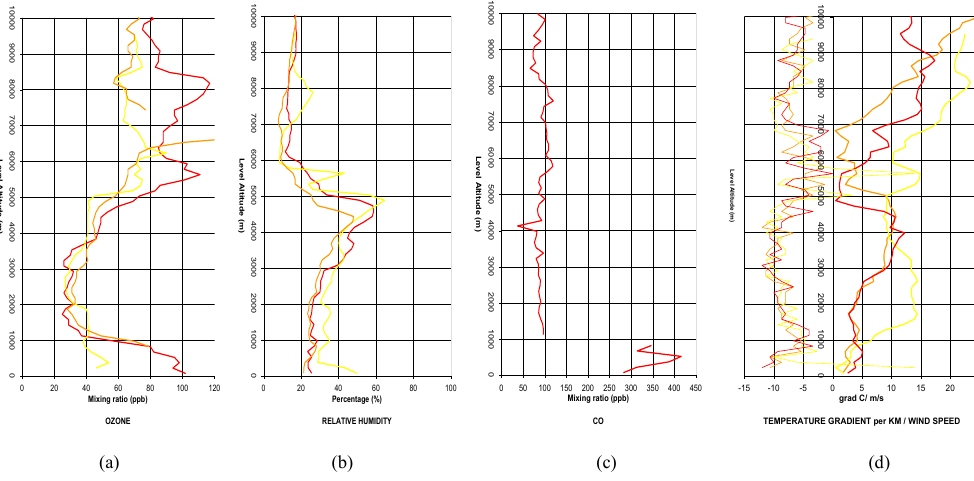
Fig. 4. (a) Vertical profiles of summer (JJA) ozone over the eastern Mediterranean airport of Cairo during the 2-day low ozone period in the lower troposphere, 26–27 July 2002 (Profiles: MA20020726043 (red), MD20020726023 (orange), MA20020727013 (yellow)); (b) same as (a) but for relative humidity; (c) same as (a) but for carbon monoxide (CO); (d) (left), same as (a) but for temperature gradient per km; (right), same as (a) but for wind speed. There are missing profiles in (c)